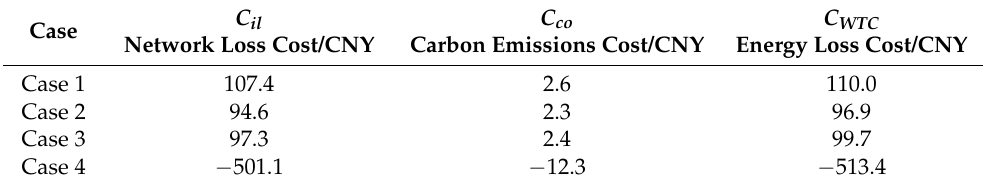
Table 10. Network loss cost and energy loss cost on four cases on another day.